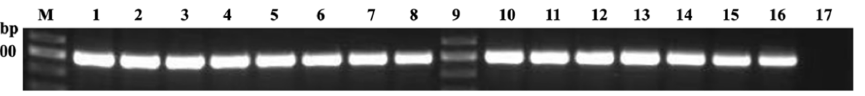
188 Figure 4. The specificity of nanoPCR. Lane M, DL 2,000 Marker; Lane 1, negative control; Lanes 2- 189 5, GPV, MDPV, DPV, and GPMV.